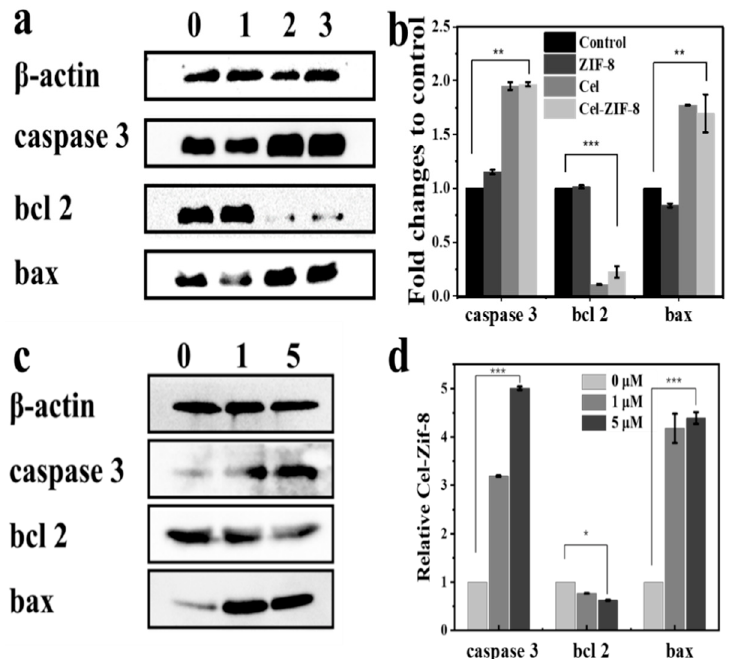
Figure 4. Effects of Cel-ZIF-8, ZIF-8, and Cel on the expression of apoptosis-related proteins, caspase 3, bax, and bcl 2, from A549 cells. ( a ) Western blot results of blank control (NO. 0), ZIF-8 (NO. 1), Cel (NO. 2), and Cel-ZIF-8 (NO. 3). ( b ) Relative contents of apoptosis-related proteins in Figure 4a derived from the software supported by the chemiluminescence apparatus. ( c ) Effect of Cel-ZIF-8 concentration (0, 1, and 5 μ M) on the expression of apoptosis-related proteins, caspase 3, bax, and bcl-2, from A549 cells assayed by Western blotting. ( d ) Relative contents of apoptosis-related proteins in Figure 4c derived from the software supported by the chemiluminescence apparatus. * Denotes p compared between Cel-ZIF-8 and control groups ( n = 5, * p < 0.05, ** p < 0.01, *** p < 0.001, significantly different compared with control).